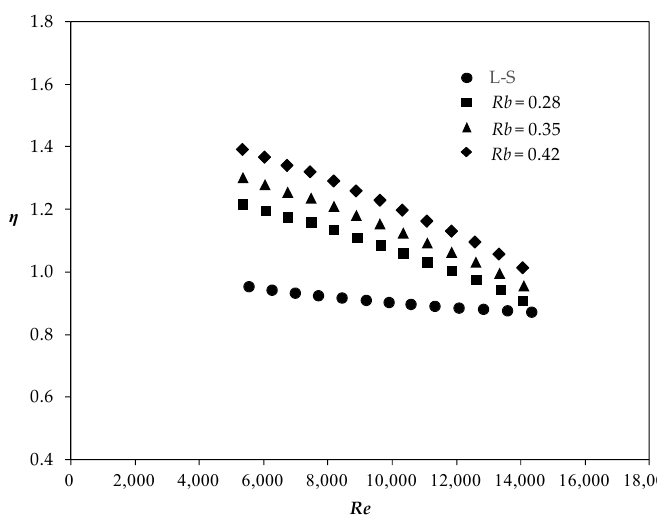
Figure 8. Effect of blockage ratio ( R b ) on the thermal performance factor ( η ) with Reynolds number ( Re ).